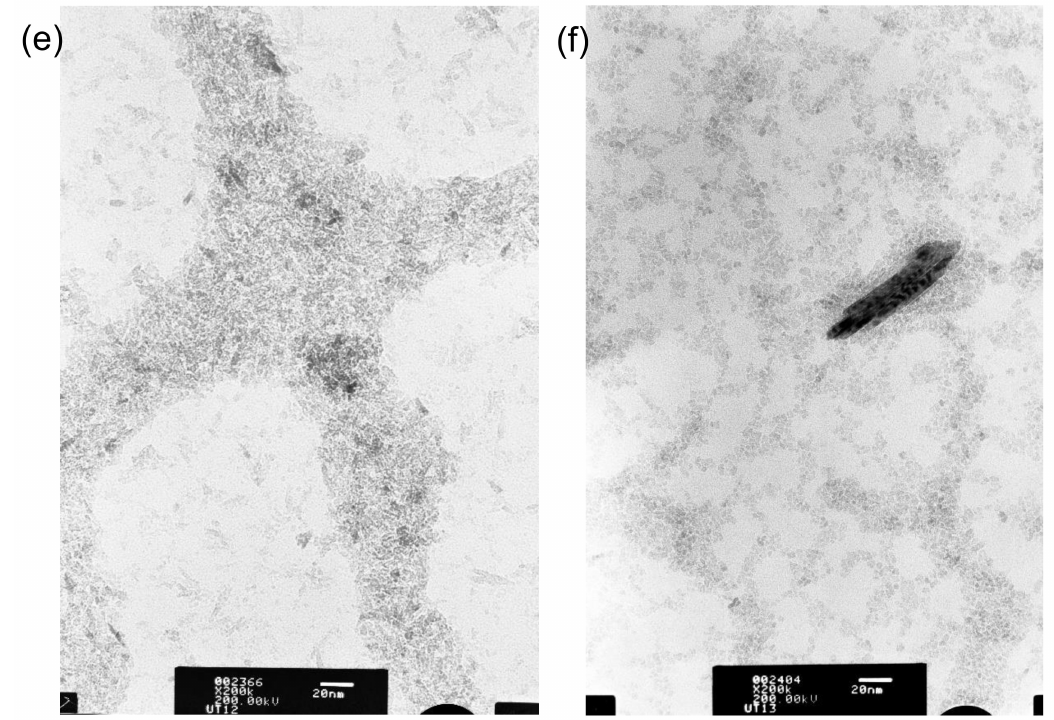
Figure 9. TEM images of particles obtained with 1.37 M TiCl 4 (with respect to the aqueous phase) and 1 wt % Span 80 (with respect to the oil) in hexadecane. The emulsification was performed with Ultra Turrax. In cases ( a – c ), the initial emulsions were prepared at 20,500 rpm for 5 min and the emulsion mixing was made at ( a ) 8000 rpm, ( b ) 13,500 rpm, and ( c ) 20,500 rpm for 10 min. In cases ( d – f ) the initial emulsions were obtained at ( d ) 8000 rpm, ( e ) 13,500 rpm and ( f ) 20,500 rpm, while the emulsion mixing was made at 20,500 rpm for 10 min.